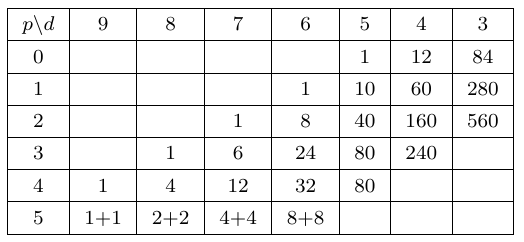
Table 25 . Number of S-branes in the p -brane multiplet in d -dimensions